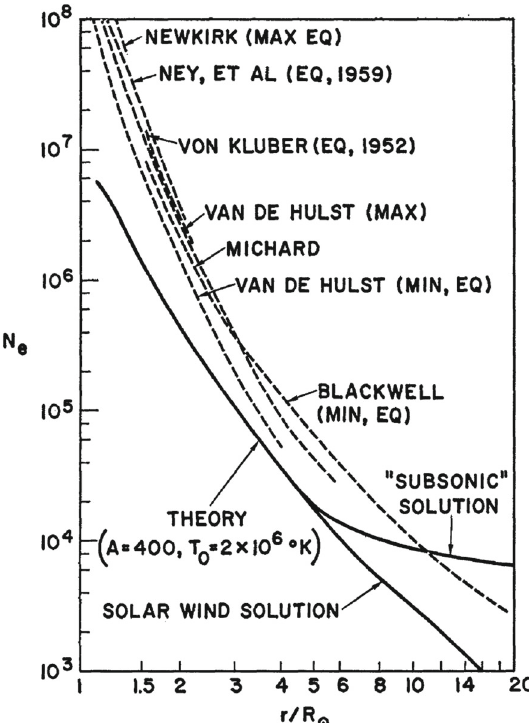
Fig. 7 Comparison between simulated and observed electron densities in the inner corona (neglecting heat conduction and viscous effects). Image reproduced with permission from Scarf and Noble (1965), copyright by